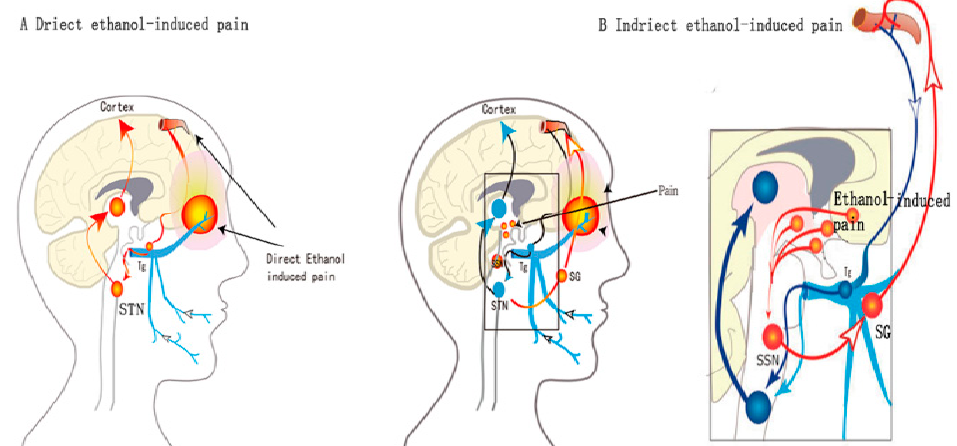
Figure 1. Ethanol-induced pain transmission in the trigeminovascular system. ( A ) Direct ethanol-induced pain: ethanol stimulates meningeal nociceptors in the Tg (trigeminal ganglion), eliciting pain signals, which are then transmitted in the spinal trigeminal nucleus (STN) to the thalamic nuclei (Th), and ultimately to the somatosensory cortex. ( B ) Indirect ethanol-induced pain: the SNN (superior salivatory nucleus) accepts ethanol-induced pain signals from different limbic and hypothalamic brain parts. The SNN transmits the pain signals to the sphenopalatine ganglion (SG); activation of the SG elicits vasodilation and the release of inflammatory factors by meningeal nociceptors, and the pain signal is then expressed through the direct pathway described